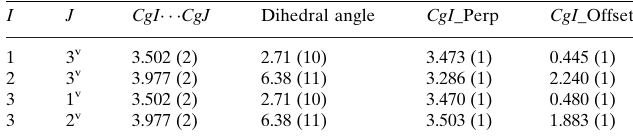
Table 2 (cid:3) – (cid:3) interactions (A˚ , (cid:4) ). Cg 1, Cg 2 and Cg 3 are the centroids of the C9/N10/C11–C14, C1–C4/C11/C12 and C5–C8/C13/C14 rings, respectively. CgI (cid:2)(cid:2)(cid:2) CgJ is the distance between ring centroids. The dihedral angle is that between the planes of the rings I and J. CgI _Perp is the perpendicular distance of CgI from ring J. CgI _Offset is the distance between CgI and perpendicular projection of CgJ on ring I